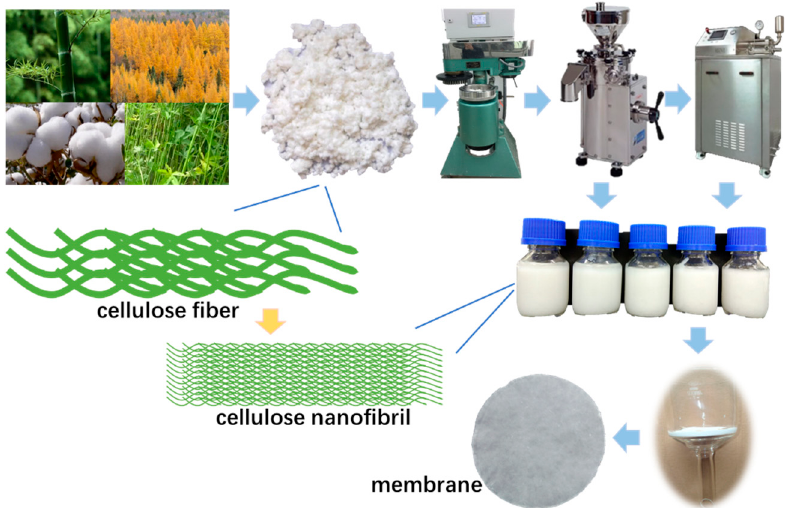
Figure 1. Schematic illustration for the preparation of the cellulose nanofibril membrane.